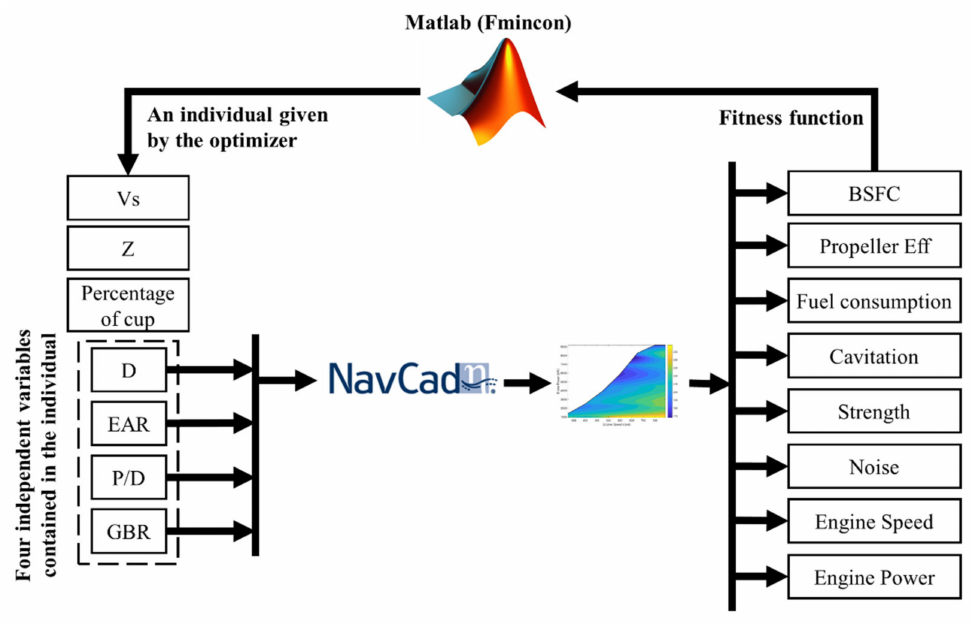
Figure 2. Schematic diagram of the propeller optimization